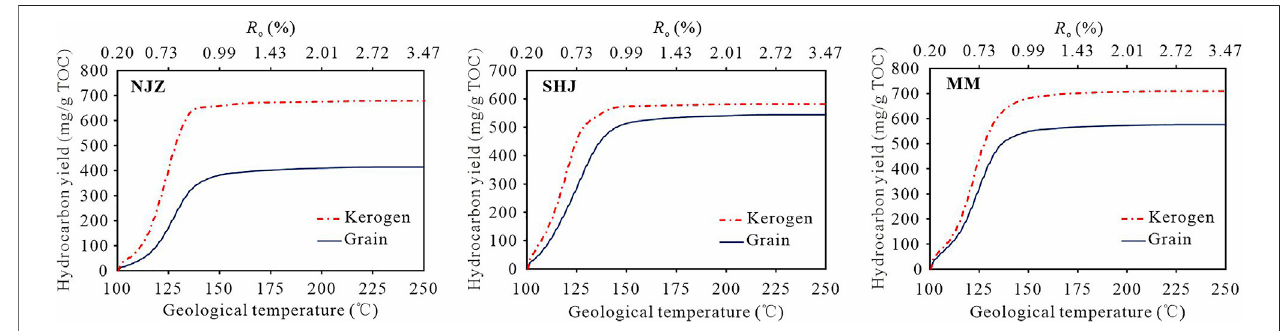
FIGURE 10 | Characteristics of hydrocarbon generation, retention, and expulsion for three samples at a geological heating rate of 3 ° C/Ma.